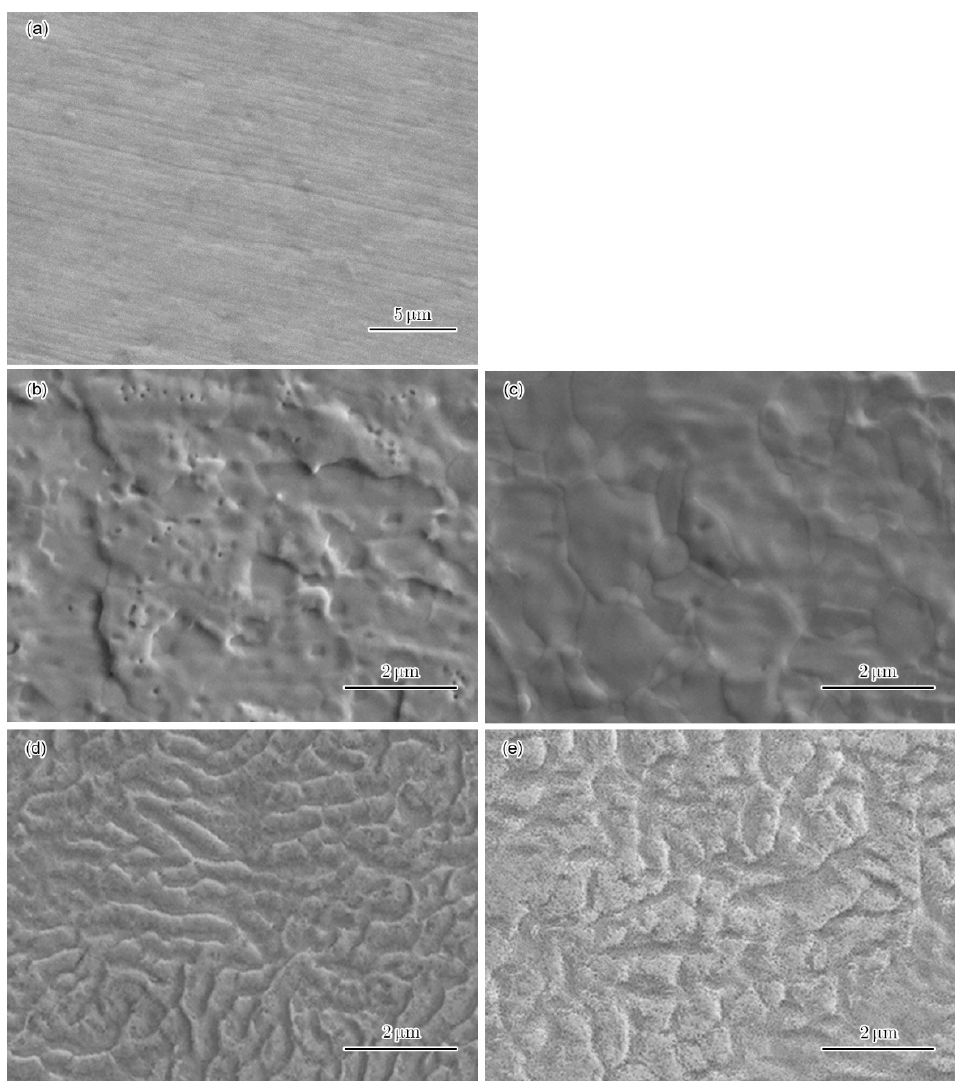
Figure 2. The surface morphology of ( a ) the nonirradiated sample and the irradiated samples ( b ) No.1, ( c )No.2, ( d ) No.3 ( d ), and ( e ) No.4. ( b ) No.1, ( c ) No.2, ( d ) No.3 ( d ), and ( e )